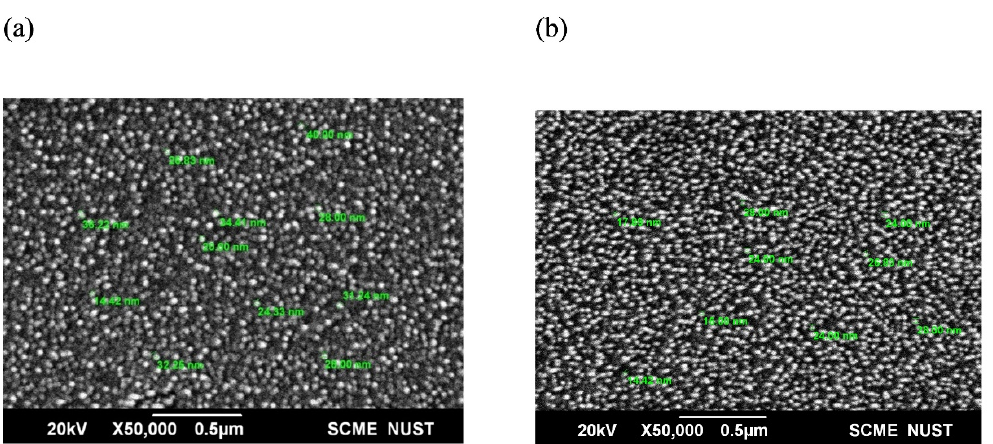
Figure 4. Sem analysis of ( a ) ZnO NPs and ( b ) Se/ZnO NPs at × 50,000 resolution using 0.5 µ m scale.